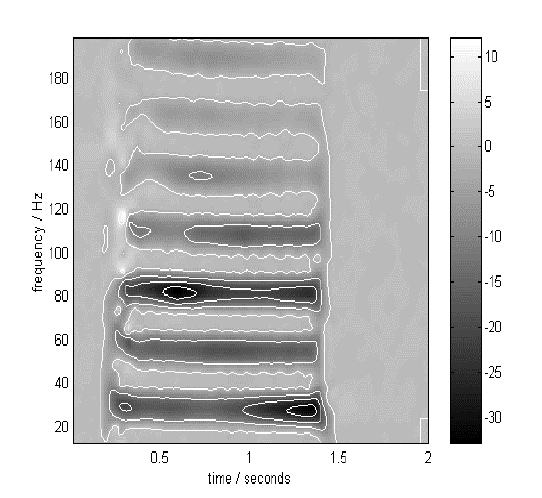
Fig. 10. Differential time-frequency map showing the difference in response measured at the middle and bottom of the model, i.e. between the maps in Figs 7(A) and